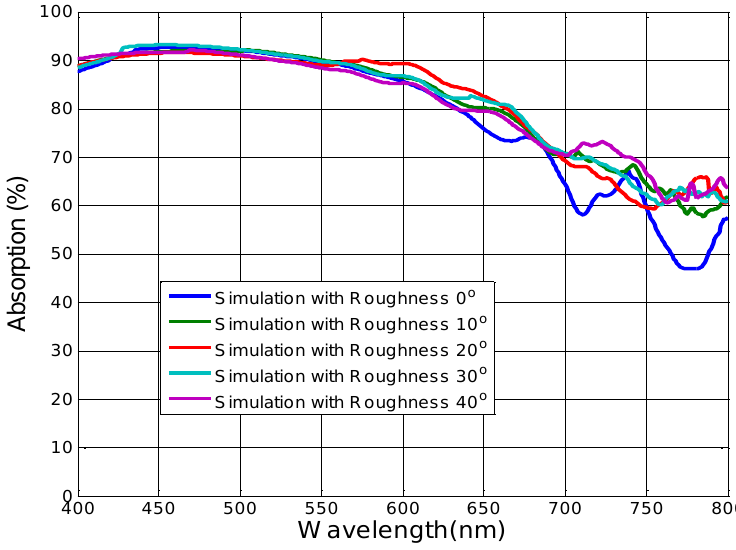
Figure 18. Absorption characteristics of the structure with an AR coating, 1 Layer DBR and an aluminum layer, at different angles of incidence. This graph shows the performance at an incidence angle of 0, 10, 20, 30 and 40 degrees. We see that the performance is even better at larger angles of incidence.